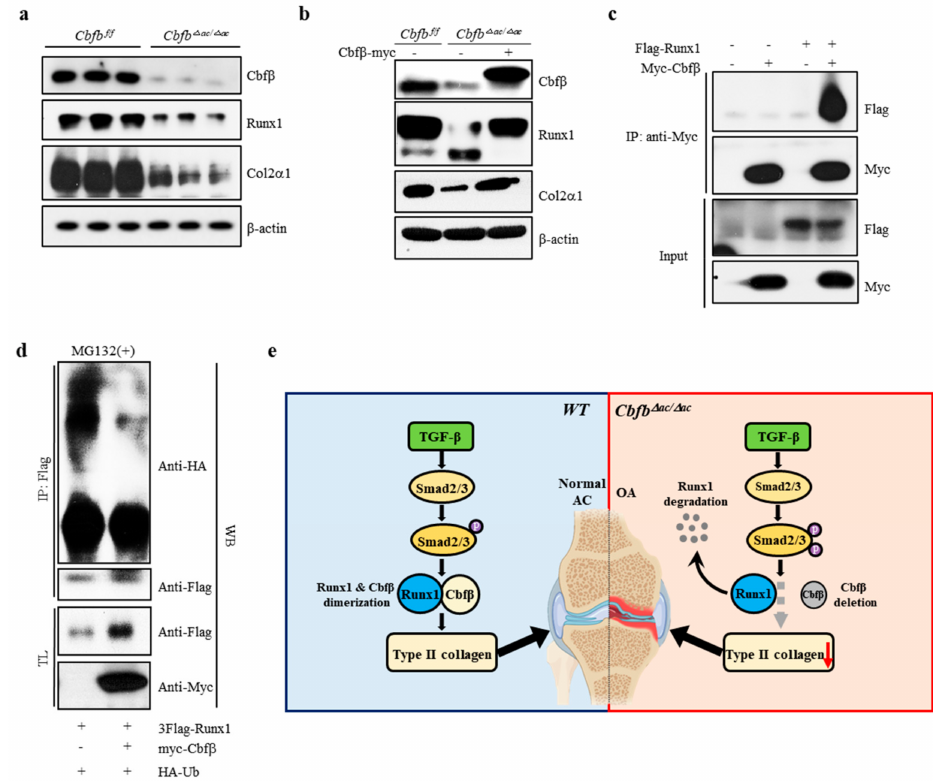
Figure 5. Requirement of Cbf β for Runx1 stabilization in articular chondrocytes. ( a ) Total protein was extracted from primary articular chondrocytes derived from WT or Cbf β (cid:52) ac/ (cid:52) ac mice, and Western blotting was performed with anti-Cbf β , -Runx1, -Col2 α 1, and - β -actin antibodies ( β -actin as the loading control. ( b ) Primary cultured articular chondrocytes derived from Cbf β (cid:52) ac/ (cid:52) ac mice were transiently transfected with Myc-Cbf β for 24 h, and the expression levels of Cbf β , Runx1, Col2 α 1, Mmp13, and β -actin were analyzed using Western blotting (WT was relative control). ( c ) Primary cultures of articular chondrocytes were co-transfected with vectors expressing Flag-Runx1 and Myc- Cbf β for 24 h. Total extracts were immunoprecipitated with anti-Myc antibody, and Runx1 was detected with anti-Flag antibody using Western blotting. ( d ) For polyubiquitination assay, ATDC5 chondrocytes were transfected with HA-Ub, Flag-Runx1, and Myc-Cbf β for 24 h and treated with 10 µ M MG132 for the last 2 h. After immunoprecipitation of Runx1 using anti-Flag antibody, Ub, Runx1, and Cbf β levels were determined with Western blotting (WB) using anti-HA, anti-Flag, and